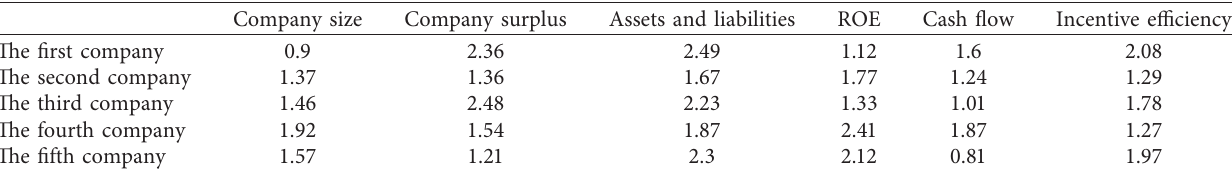
Figure 3: Listed company governance efficiency. Table 4: Executive